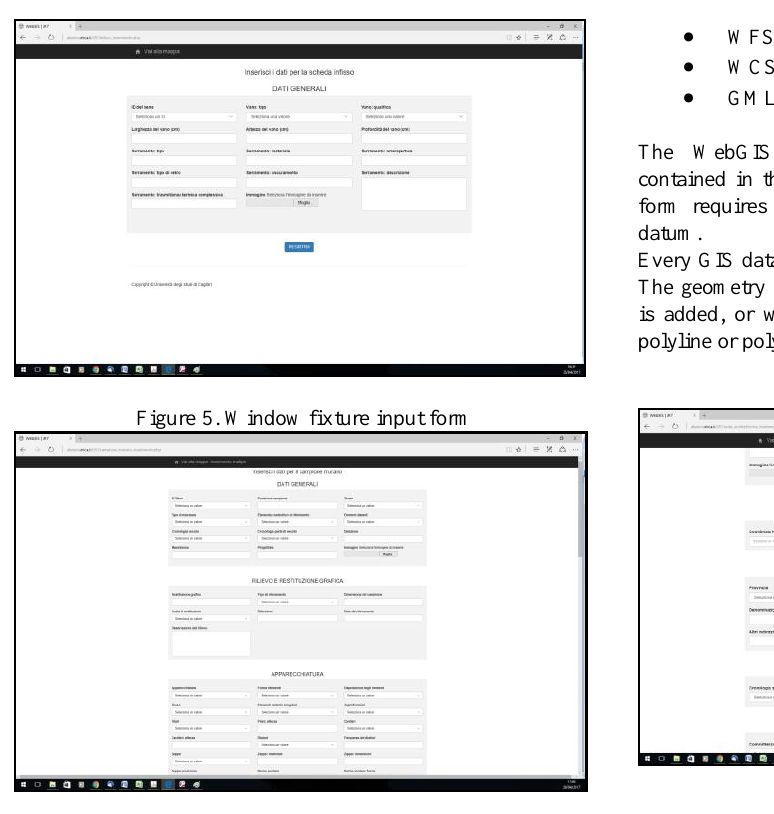
Figure 6. Masonry sample input form